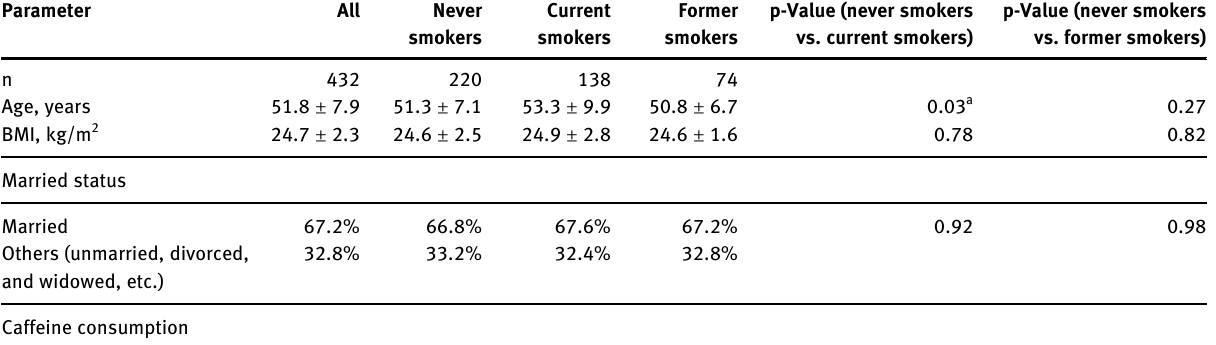
Table  : Baseline characteristics of the subjects with postmenopausal osteoporosis based on smoking status.